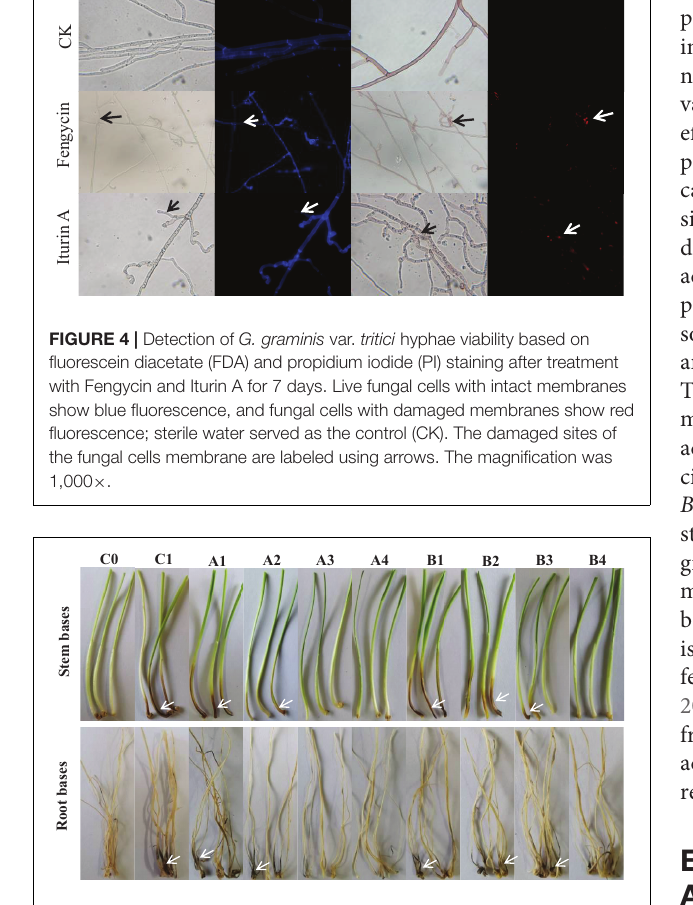
FIGURE 5 | Biocontrol effect of different concentrations of fengycin and iturin A on take-all disease of wheat seedlings. C0, blank control; C1, pathogen control; A1 ∼ A4, the effect of different concentrations of fengycin (10, 50, 100, and 500 µ g/ml, respectively) on take-all disease of wheat seedlings; B1 ∼ B4, the effect of different concentrations of iturin A (10, 50, 100, and 500 µ g/ml, respectively) on take-all disease of wheat seedlings. The white arrows point to the tissues (stem bases and root bases, respectively) of wheat seedlings infected by pathogen G. graminis var. tritici